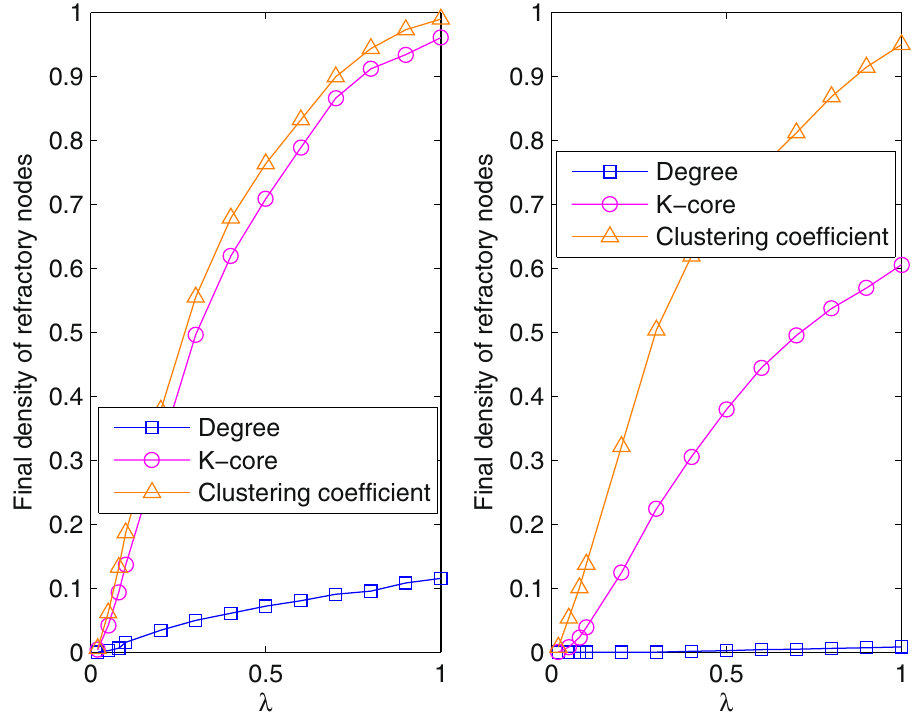
Figure 4. Final density of refractory nodes versus λ . The underlying network is the real network, and δ = 0.2. ( a ) γ = 0.01; ( b ) γ = 0.05. The results are averaged over 100 realization.